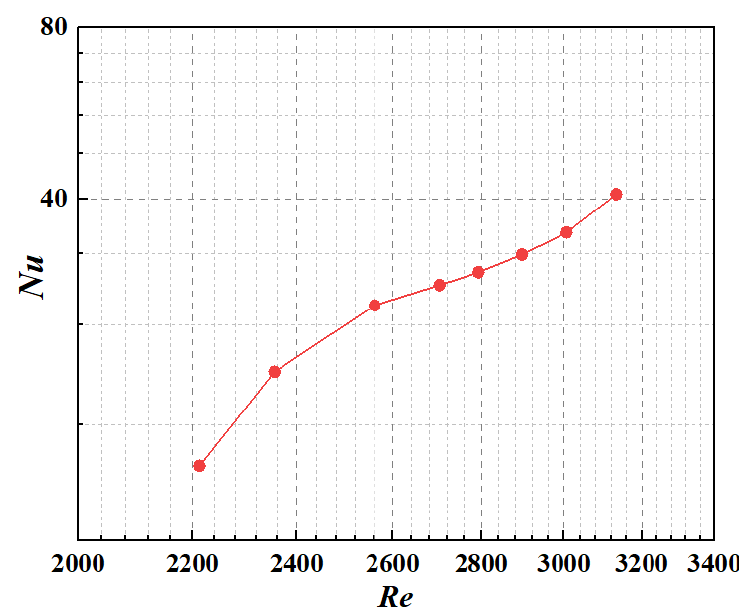
Figure 9. Variation in the Nusselt number with the Reynolds number.